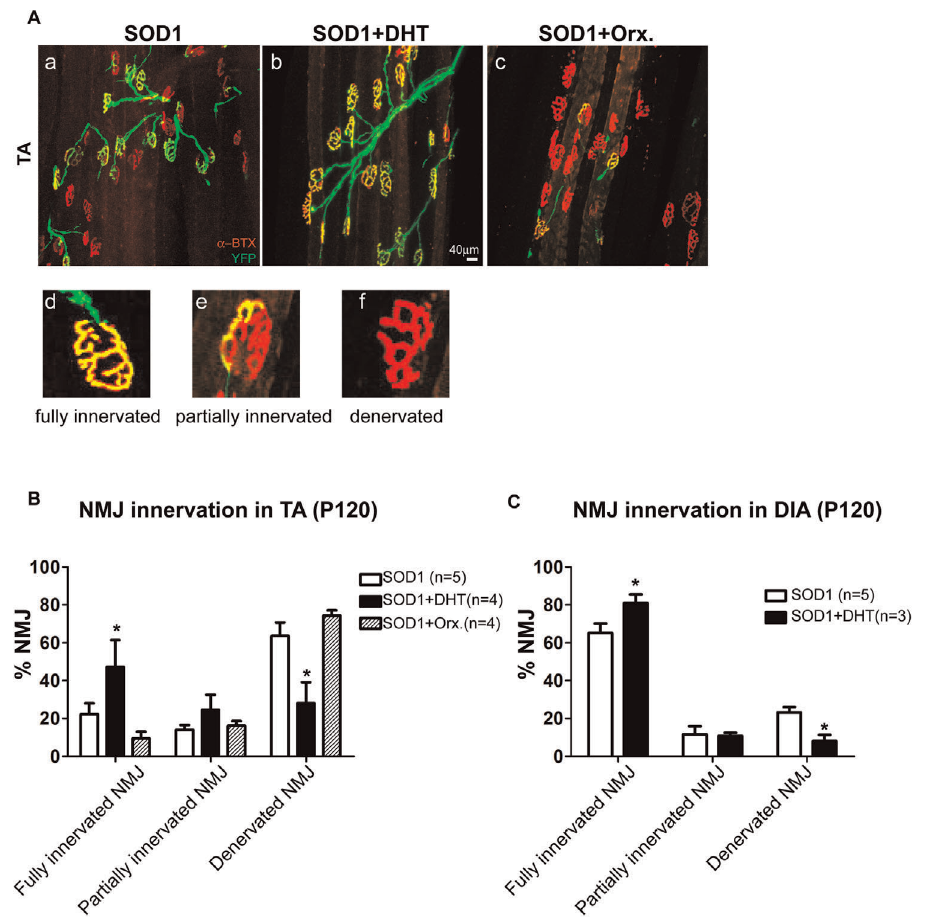
Figure 5. DHT ameliorates denervation at neuromuscular junctions SOD1 mice. SOD1/YFP double transgenic mice expressing yellow fluorescence protein (YFP) in all motor nerves were implanted with either a DHT-filled or an empty silastic tube, or orchidectomized at P75, and the TA muscle and the diaphragm (DIA) muscle were collected at P120, and stained with anti- a -bungarotoxin to label post-synaptic acetylcholine receptor (AChR) clusters. A: When a pre-synaptic nerve terminal (in green) fully overlaps with the post-synaptic AChR clusters (in red), the neuromuscular junction (NMJ) is defined as a ‘‘fully innervated NMJ’’ (d). However, if a nerve terminal is partially overlapped with AChR, or is completely absent, leaving only AChR, the NMJ is defined as a ‘‘partially innervated NMJ’’ (e) or a ‘‘denervated NMJ’’ (f), respectively. DHT-treated SOD1/YFP mice (b) showed improved NMJ innervation in the TA muscle compared with control SOD1/YFP mice (a). However, orchidectomy in SOD1/ YFP mice aggravated denervation at NMJs (c). B: Quantification of NMJs at P120 in the TA muscle of DHT-treated, control, and orchidectomized SOD1/YFP mice is shown. Compared to control SOD1/YFP mice, which showed 22.3 6 5.7% of fully innervated NMJs, DHT-treated SOD1/YFP mice showed 47.3 6 14.1% of fully innervated NMJs. Orchidectomized SOD1/YFP mice showed only 9.6 6 3.4% of fully innervated NMJs. C: Quantification of NMJs at P120 in the DIA muscle of DHT-treated, and control SOD1/YFP mice is shown. Compared to SOD1/YFP mice, which showed 65.2 6 5.6% of fully innervated NMJs, DHT-treated SOD1/YFP mice showed 81.0 6 5.5% of fully innervated NMJs. Data are mean 6 SEM. * p ,